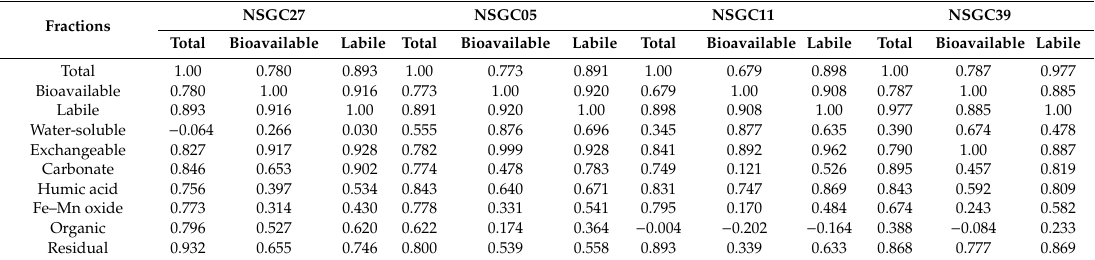
Table 6. Correlation coefficients for total, bioavailable, and labile Cd in each profile.